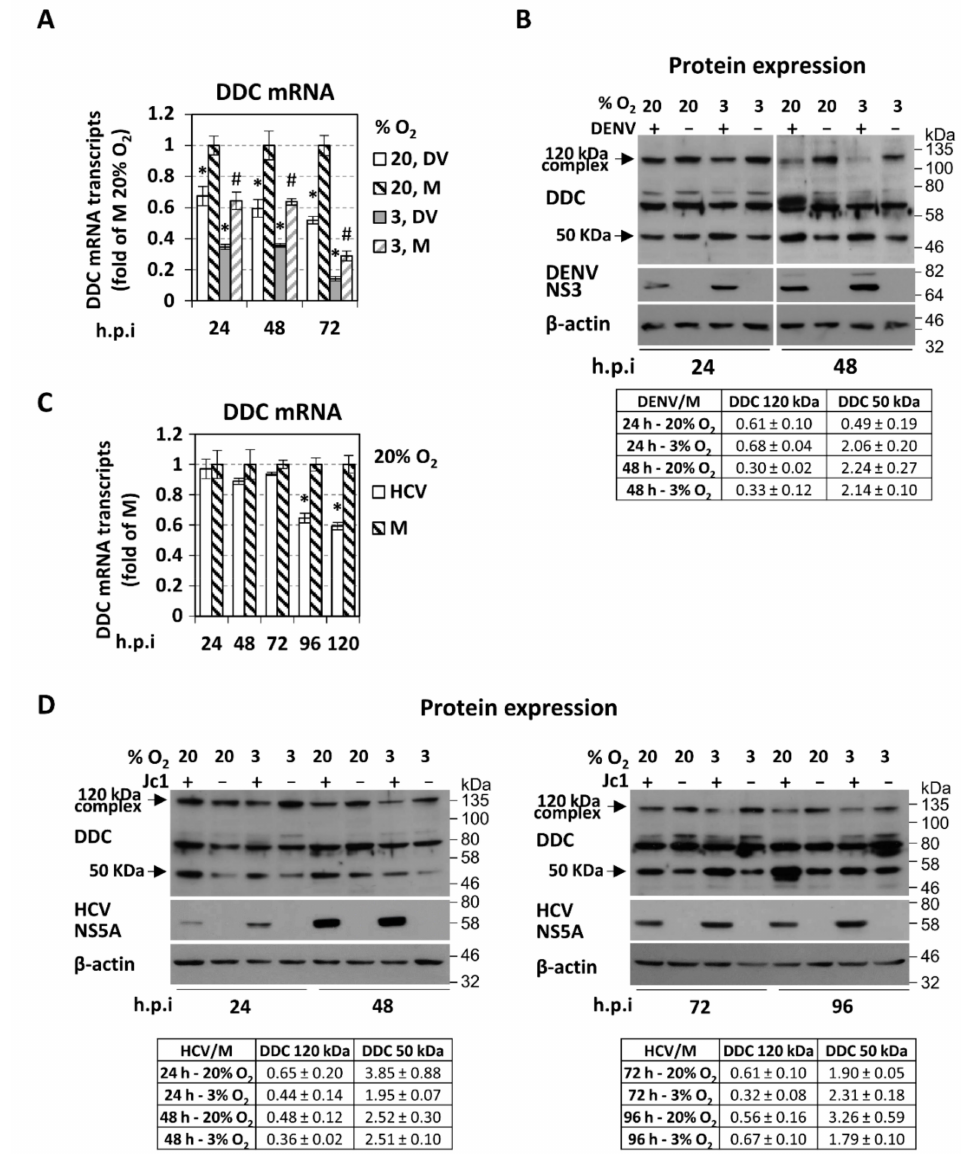
Figure 1. The impact of dengue (DENV) and hepatitis C (HCV) virus infection on the intracellular levels of l -dopa decarboxylase (DDC) mRNA and protein under 20% and 3% v / v O 2 . ( A , B ) Huh7 cells, preincubated at 20% or 3% v / v O 2 for 18 h, were inoculated with cell-culture produced DENV virus particles (DV-2 16,681 strain, MOI = 1) for 4 h, washed twice with fresh culture medium, and further cultured for the indicated hours post-infection (p.i) under the respective oxygen condition. ( A ) Reverse transcription quantitative PCR (RT-qPCR) analysis of the intracellular total DDC mRNA levels from Huh7 DENV-infected cells. Values are expressed relative to the ones derived from mock-infected (M) cells under 20% O 2 at each time-point. mRNA levels of the housekeeping gene 14-3-3-zeta polypeptide (YWHAZ)wereusedfornormalization. Barsrepresentmeanvaluesfromthreeindependentexperiments in triplicate. Error bars indicate standard deviations. * p < 0.001 vs. mock, # p < 0.001 vs. 20% O 2 . ( B ) (Top) Western blot analysis performed with (from top to bottom) anti-DDC-CT, anti-DENV NS3, or anti- β -actin antibodies. β -actin was used as loading control. Numbers on the right refer to the positions of molecular mass marker proteins. A representative experiment of three independent repetitions is shown. (Bottom) Densitometry analysis data for 120 kDa and 50 kDa DDC (mean values from three independent repetitions) were normalized to β -actin and to the values obtained